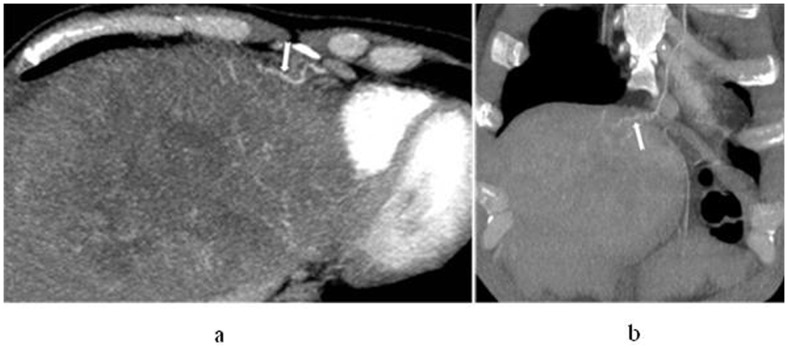
In a 45-year-old man with hepatocellular carcinoma in S8, left internal mammary artery participates in blood supply for the tumour.Axial (a) and coronal (b) maximum intensity projection display that left mammary artery gives off branches into the lesion, and the branches are twist and enlarged (white arrow).